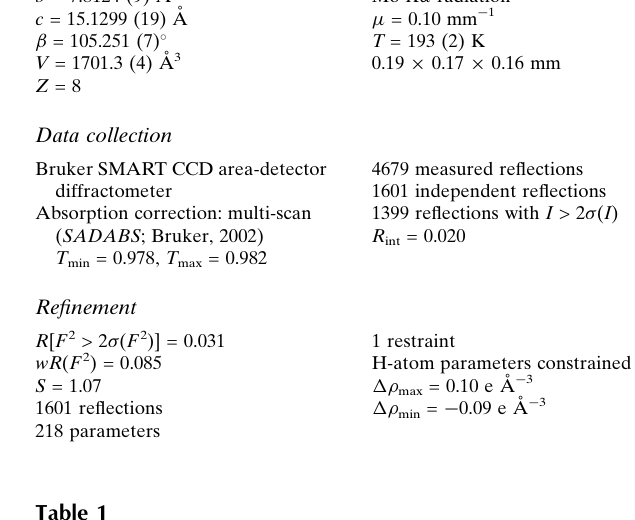
Hydrogen-bond geometry (A˚ , (cid:1)